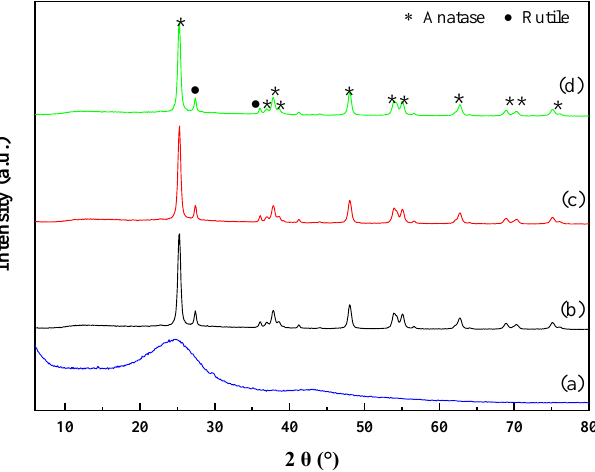
Figure 3. X-ray diffractograms of ( a ) LAC, ( b ) Ti, ( c ) TiLAC-7/3 and ( d ) TiLAC-9/1.